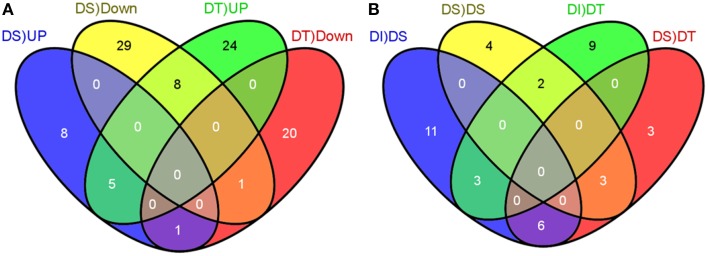
The Venn diagram illustrates the numbers of common and unique differentially expressed miRNAs induced by drought stress. Up- and Down-regulated miRNAs (≥2 or ≤ −2 fold changes) under the control and drought stages of drought-susceptible and tolerant genotypes of sorghum are given in (A) with the confidence of P ≤ 0.05. The numbers of extended drought-responsive miRNAs with the confidence of ≥5 reads at least in one genotype are illustrated in (B).